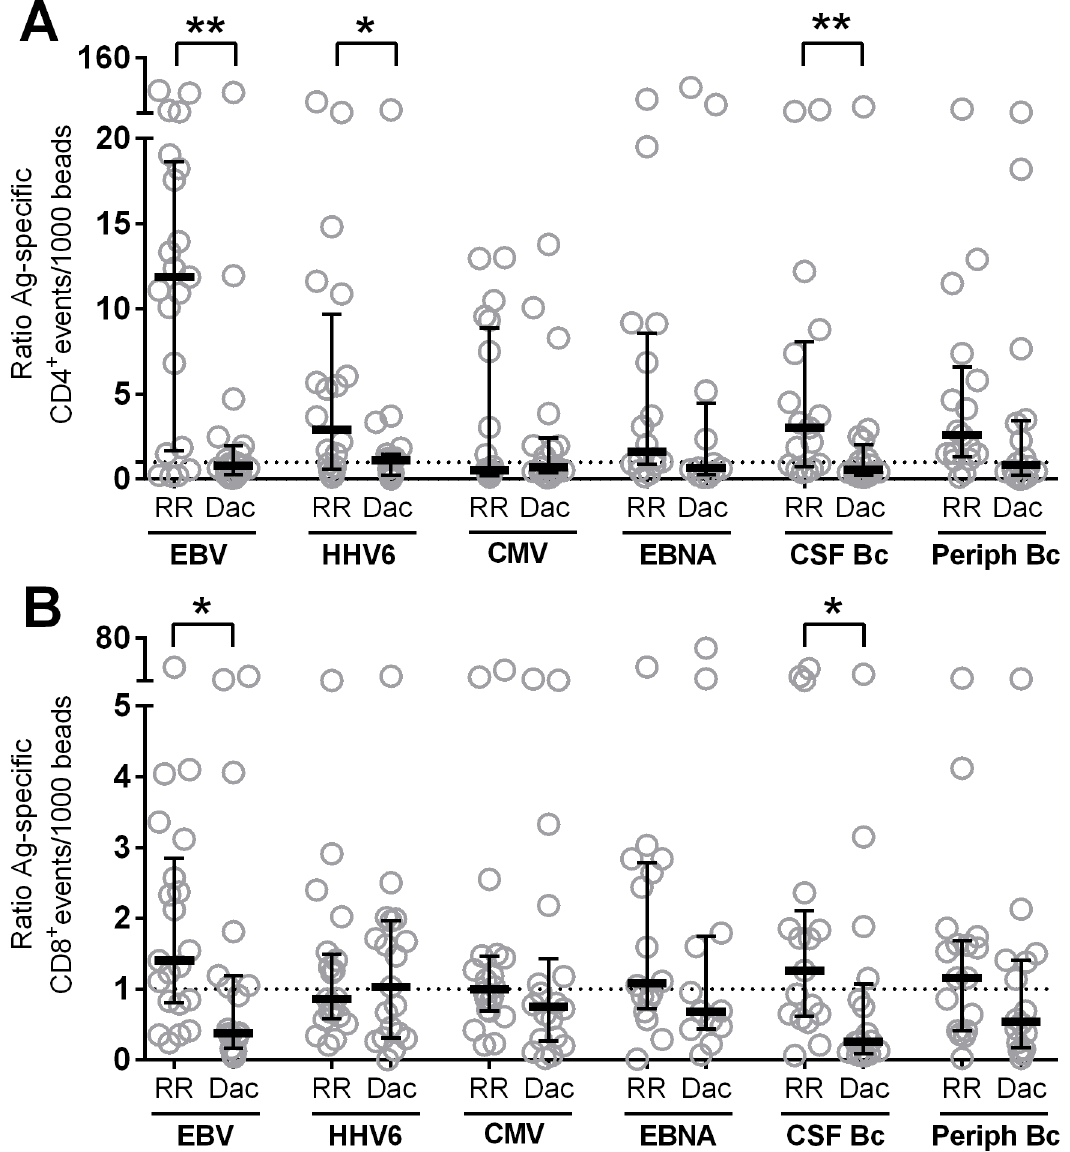
Figure 6. Daclizumab-induced normalization of Ag-specific T cell responses. Intracellular cytokine secretion of each research subject was analyzed for IFN- c + , TNF- a + and double positive T cell events. The sums of all cytokine positive events were normalized to beads. Ratios of intrathecal to peripheral T cell reactivities of un-treated (RR) and DAC HYP-treated RRMS patients (Dac) were calculated to foreign Ag’s for CD4 + ( A ) and CD8 + T cells ( B ). Ratios greater than one (dotted line) indicate enrichment of Ag-specific T cell events in the intrathecal compartment; ratios lower than one represent less pronounced intrathecal T cell responses. Horizontal bars represent median values; vertical lines represent interquartile ranges. *0.01 , p , 0.05, **0.001 , p , 0.01, ***p , 0.001 .